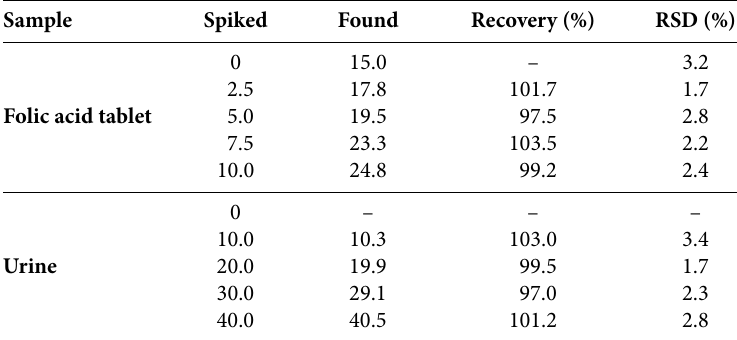
Table 2. Determination of folic acid in folic acid tablet and urine samples. All the con- centrations are in μM (n=5). Sample Spiked Found Recovery